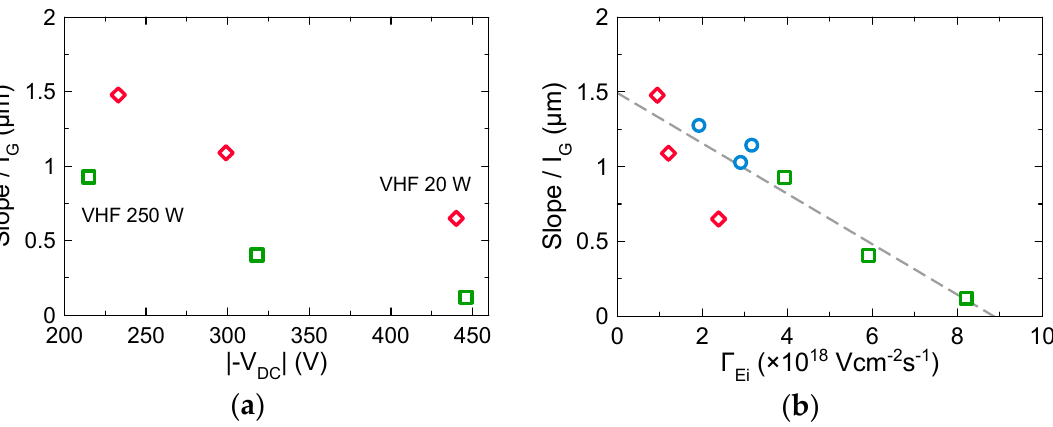
Figure 7. The Slope/I G as functions of ( a ) the magnitude of the negative self-bias voltage |- V DC | and ( b ) the ion bombardment energy flux Γ E i . Diamonds ( ◇ ) correspond to 20 W in VHF power, squares ( □ ) correspond to 250 W in VHF power, and circles ( ○ ) correspond to 50, 100, and 200 W in VHF power with 50 W of RF bias power.